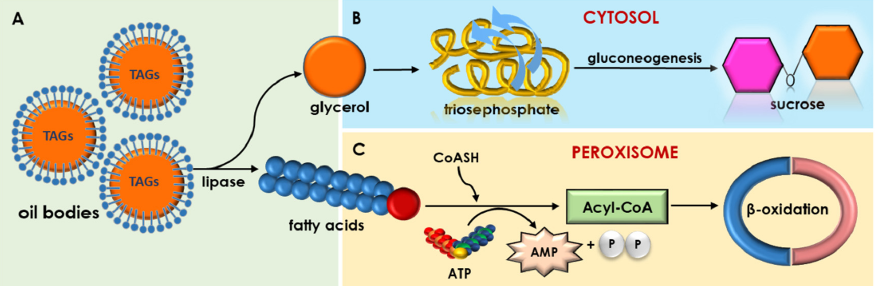
Figure 3. General pathway for lipid degradation in seeds. ( A ) Triacylglycerols are hydrolyzed into its glycerol and fatty acid components through the activity of lipases. ( B ) Glycerol is transported to the